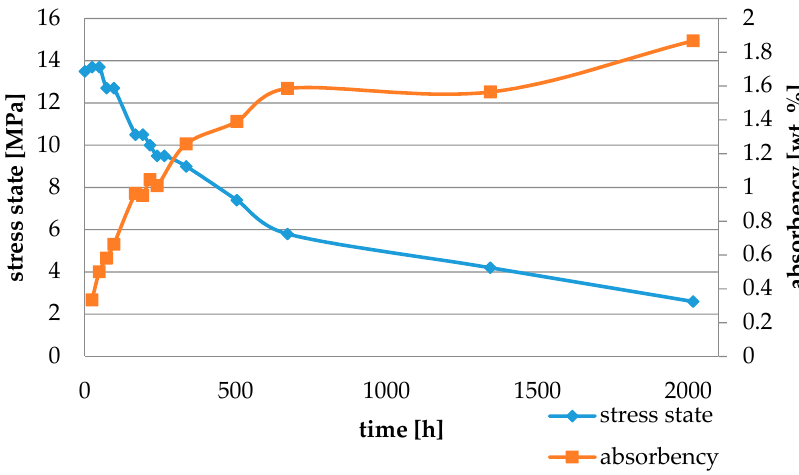
Figure 12. The influence of water sorption (2016 h water ageing) on the absorbency and contraction stress generated during the photopolymerization of Rely U200.